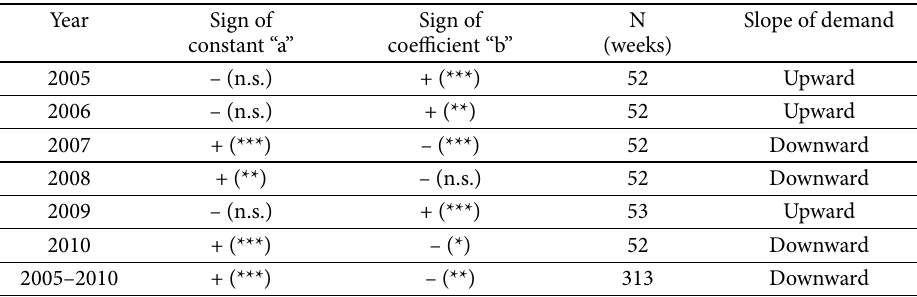
Sign of coefficient “b”